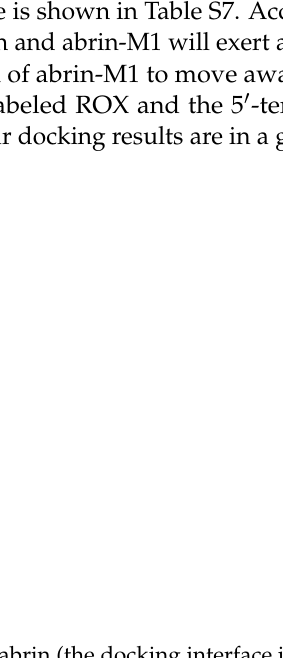
Figure 11. Docking results of abrin-M1 and abrin (the docking interface is shown in yellow).